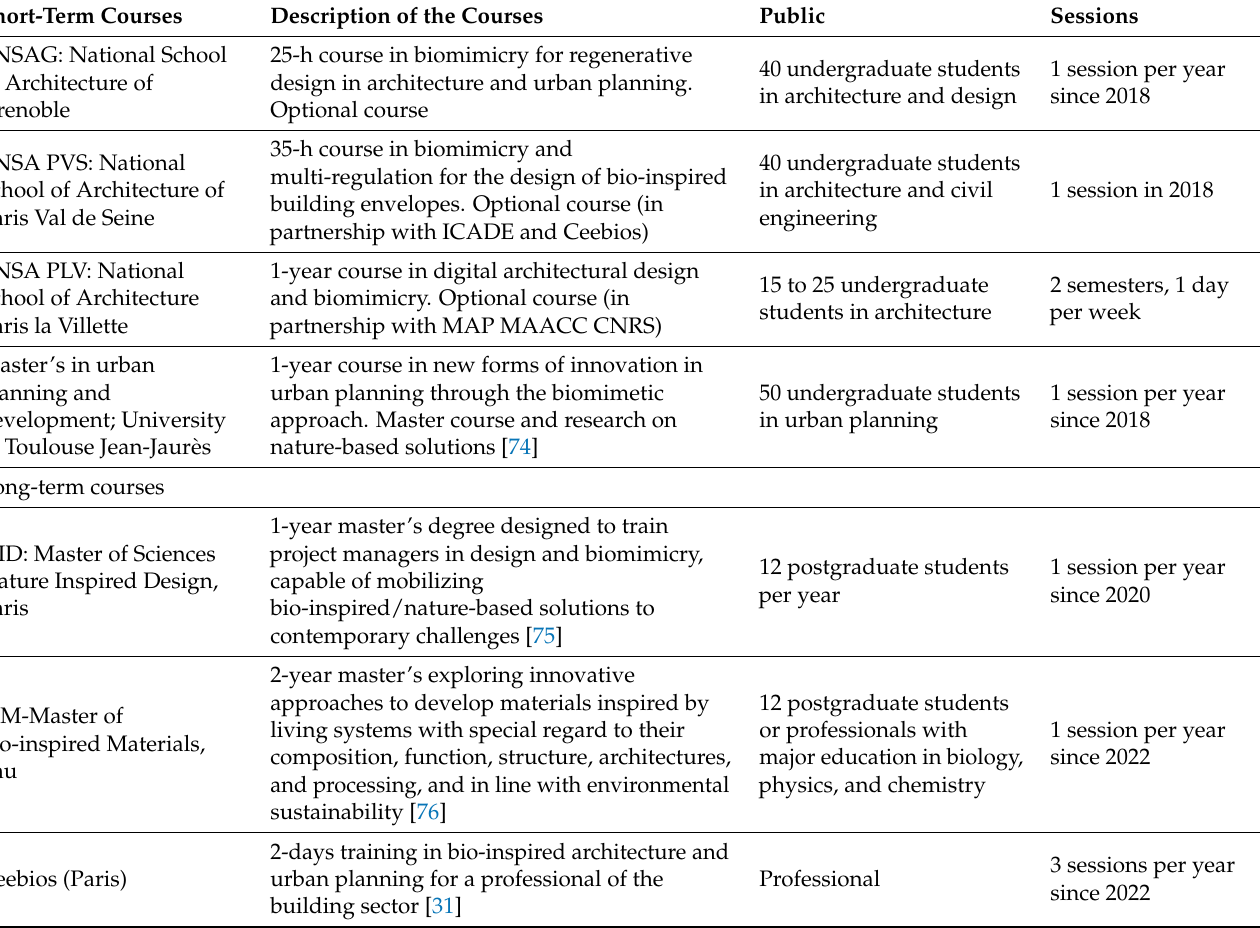
in Table 4: (i) short-term courses for undergraduate students and (ii) long-term courses for postgraduate students and professionals. The literature also counts a large range of introductive courses in biomimicry which is completed in less than two hours. These courses are not considered in that section. Table 4. Overview of the diversity of courses in biomimicry in architecture and urban planning taught by French